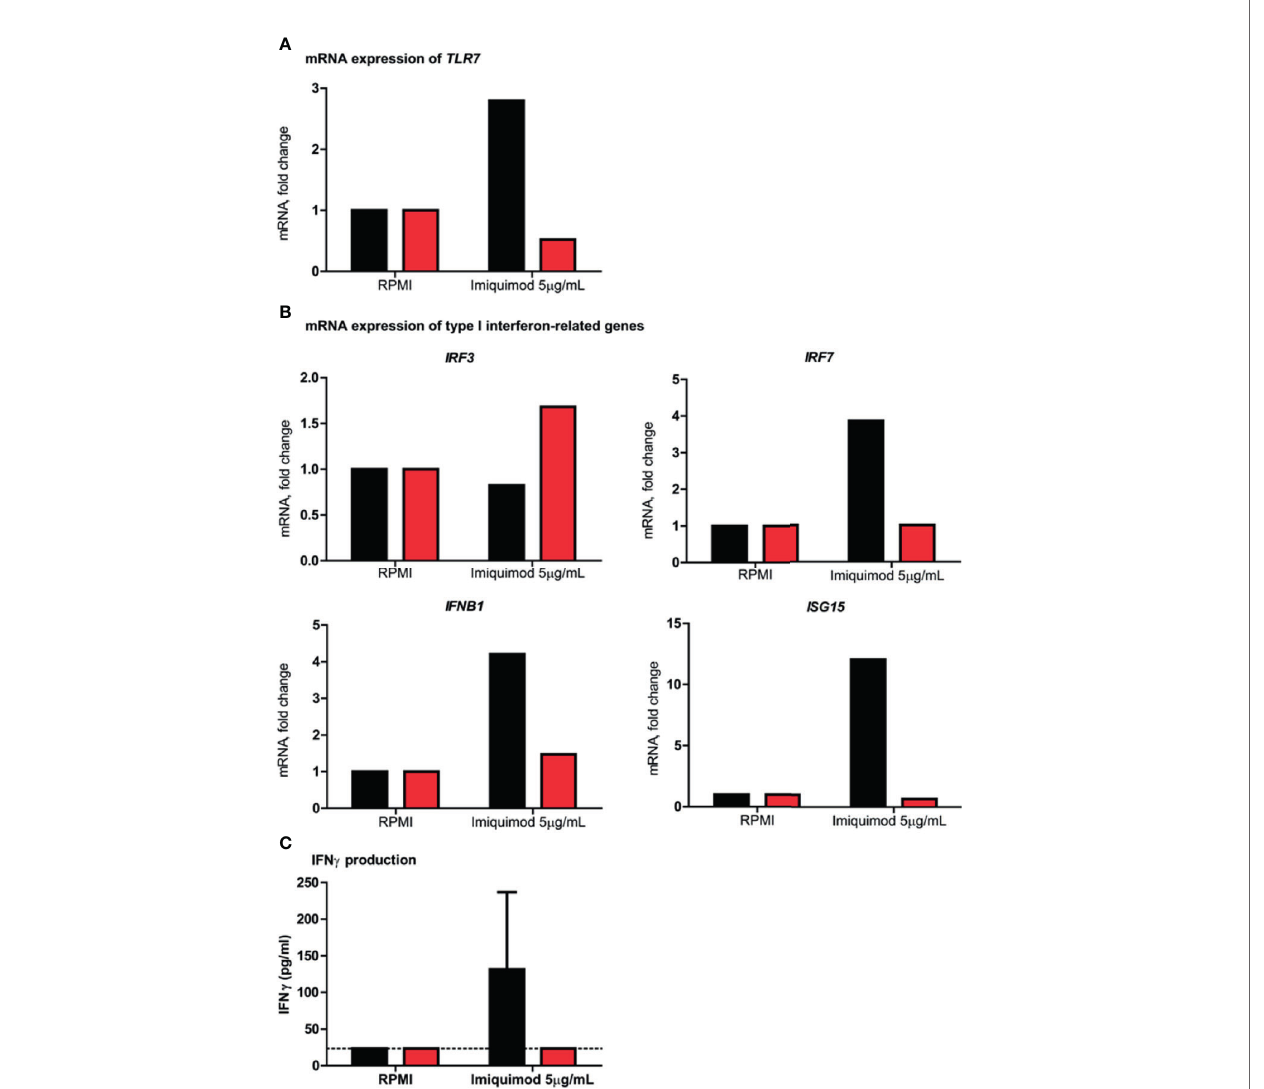
FIGURE 2 | Assessment of ex vivo/in vitro type I and II interferon responses in peripheral blood mononuclear cells. In all panels, patient 13 is indicated in red and the healthy controls in black. (A) shows the fold change in TLR7 mRNA expression in patient 13 and a healthy male control after stimulation for 4 hours with the TLR7 agonist imiquimod, compared to the negative medium control RPMI. (B) displays the fold change in mRNA expression of type I IFN – related genes IRF3, IRF7, IFNB1 and ISG15 induced by imiquimod as compared to RPMI. (C) shows the production of IFN- g production after imiquimod stimulation for 7 days as compared with unstimulated control cells (RPMI) from patient 13 and two healthy male controls. The dotted line indicates the assay ’ s detection limit. Abbreviations: IRF3 , interferon regulatory factor 3; IRF7 , interferon regulatory factor 7; ISG15 , interferon-stimulated gene 15; and IFNB1 , interferon beta